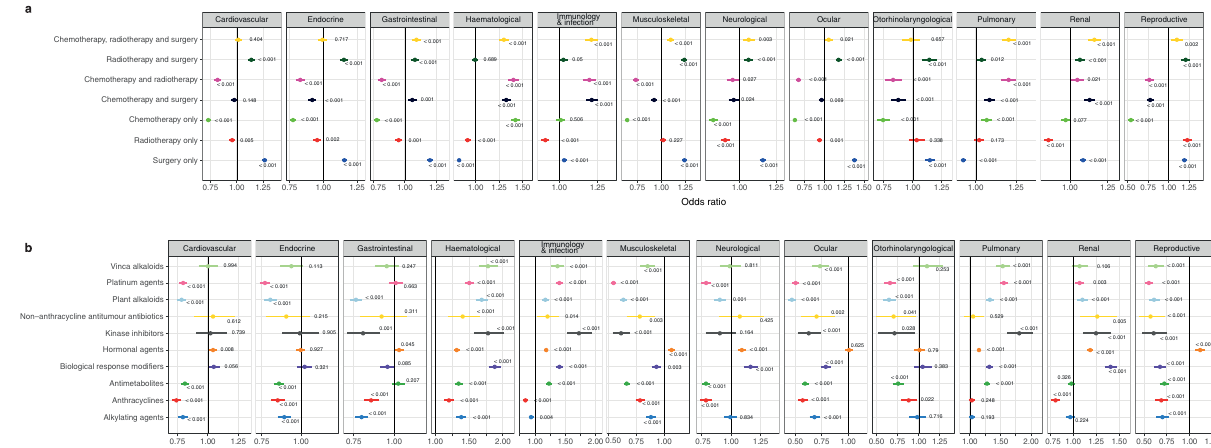
Fig. 5 | Multivariable logistic regression analysis ofhealthconditionoutcomes among cancer survivors by different exposures. a Treatment type. b Chemotherapy agent. Forest plots show data presented as odds ratios and error bars represent 95% con fi dence intervals. P values are indicated on the plot. The Wald test isemployed. Source data are provided asa Source Data fi le. The number of patients within each treatment category were as follows: chemotherapy only (19,691), surgery only (80,491), radiotherapy only (20,662), chemotherapy and